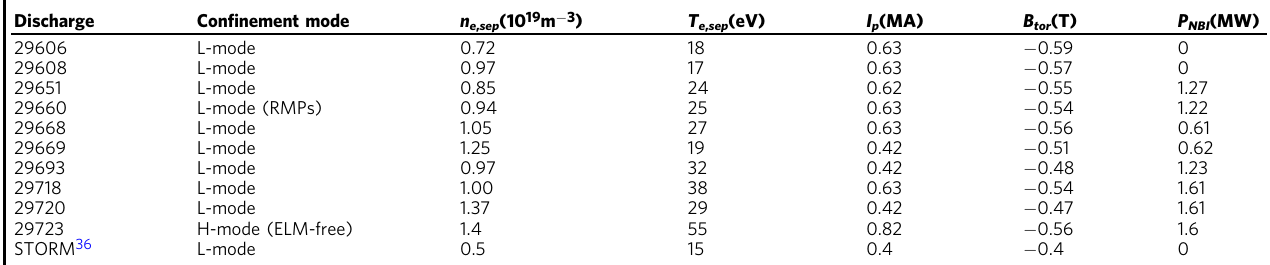
Table 1 Survey of plasma parameters from MAST and the STORM code used for analysis. The discharge number, con fi nement mode of the discharge, plasma density n e , sep and electron temperature T e , sep (measured at the upstream separatrix); plasma current I p ; toroidal magnetic fi eld B tor ; and, input heating power P NBI are shown for all discharges/simulations analysed. RMPs refer to Resonant Magnetic Perturbations for Edge Localised Mode (ELM) control.